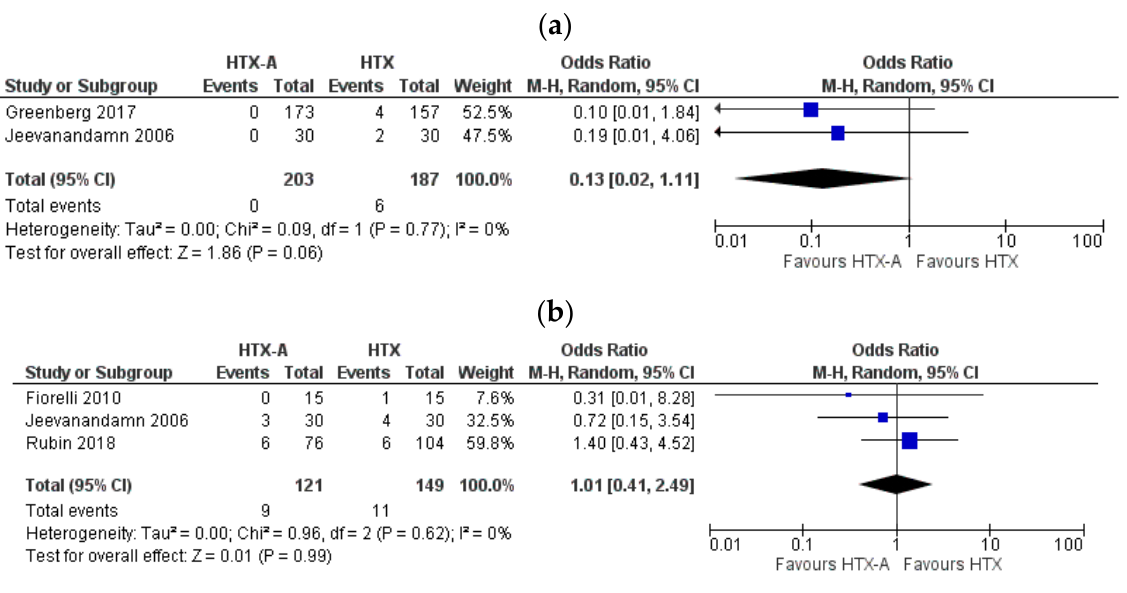
Figure 4. Forest plot depicting: ( a ) reoperation rate on tricuspid valve after transplantation; ( b ) 1-year survival.